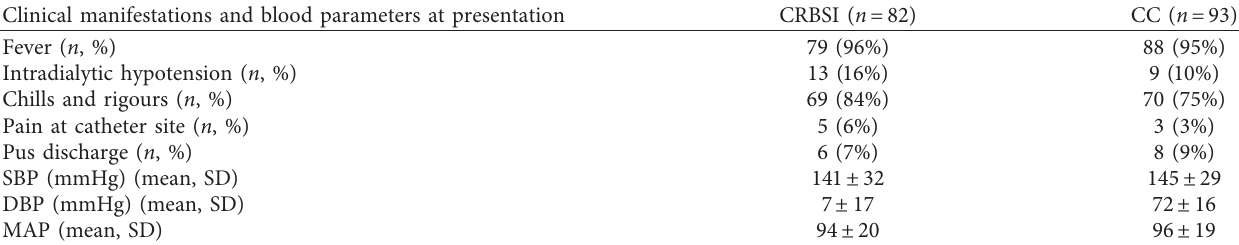
Table 2: Clinical characteristics and blood parameters of CRBSI and CC groups.